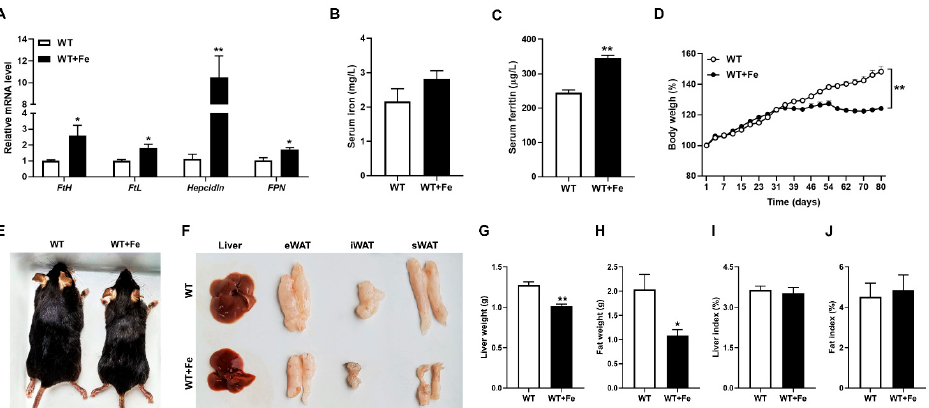
Figure 1. A high-iron diet reduced the body weight and changed iron metabolism of mice. ( A ) Hepcidin , FtH , FtL and FPN mRNA levels in liver. ( B ) Serum iron concentration. ( C ) Serum ferritin concentration. ( D ) Body weight. ( E ) Representative images of body size of mice. ( F ) Representative images of liver, eWAT, iWAT, and sWAT. ( G ) Liver weight. ( H ) Fat weight. ( I ) Liver index. ( J ) Fat index. * p < 0.05, ** p < 0.01.